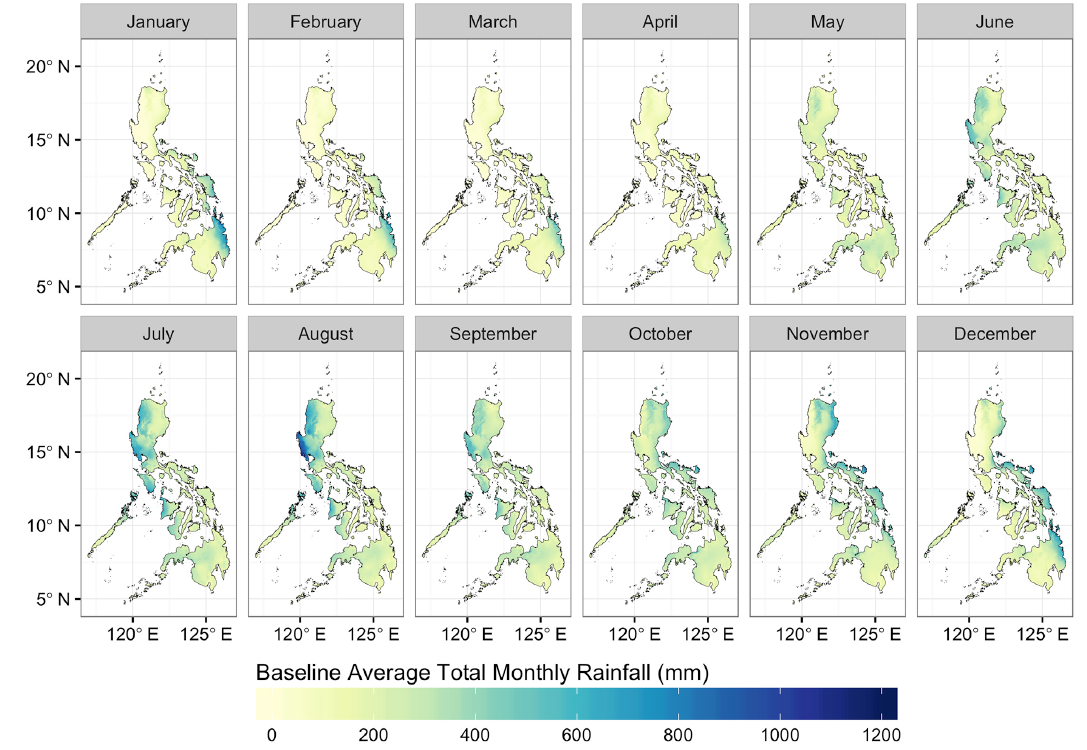
Fig. 2. Spatial distribution of average total monthly rainfall in the Philippines under baseline climate condition (1950–2000).